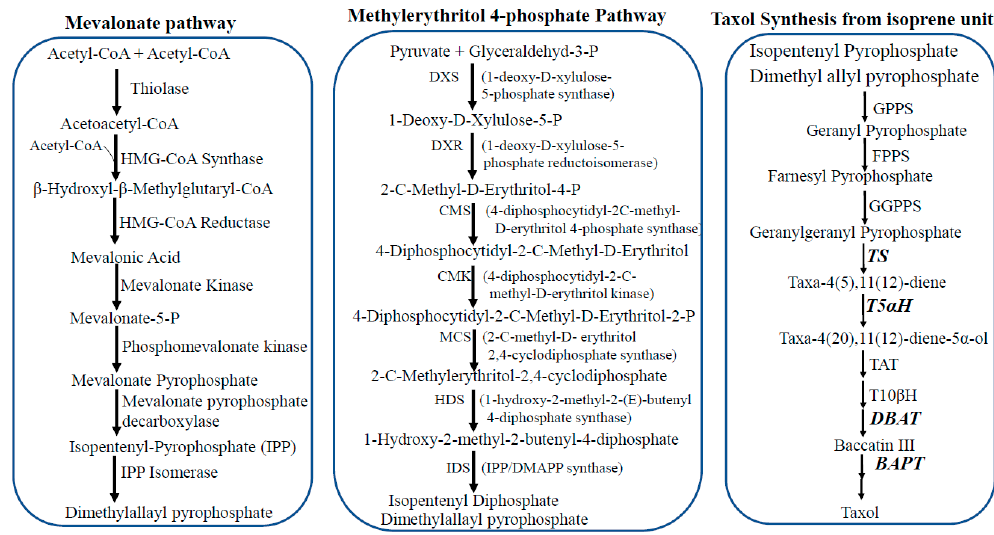
Figure 2. Biosynthetic pathways of isoprene units such as isopentenyl pyrophosphate (IPP) and dimethylallyl pyrophosphate (DMAPP). Mevalonate pathway, Methylerythritol 4-phosphate and